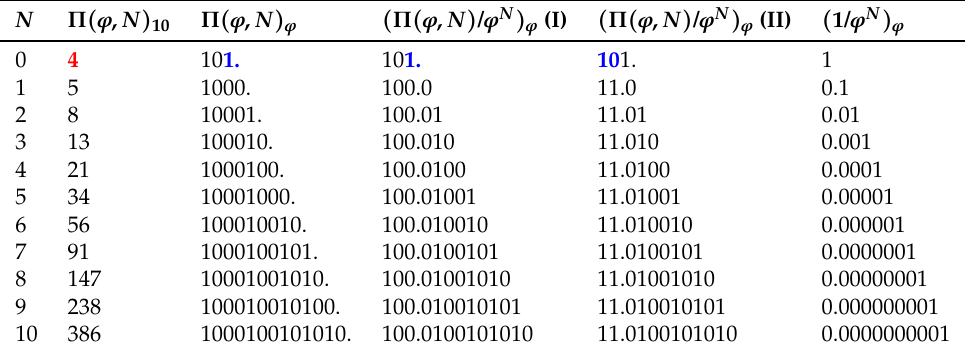
Table 6. Number of collisions Π ( ϕ , N ) given by (13) for b = ϕ . The first column is N . The second column is Π ( ϕ , N ) in the decimal base. The third column is the integer part of Π ( ϕ , N ) written in the base π . The fourth column is the number π with N digits in the fractional part (Type I) in the base π . The fifth column is the number π with N digits in the fractional part (Type II) in the base π . The sixth column gives the systematic error according to Equation (55). The case where approximation (14) fails as compared to (13) is highlighted by red. The blue bold digit is predicted incorrectly by the Galperin